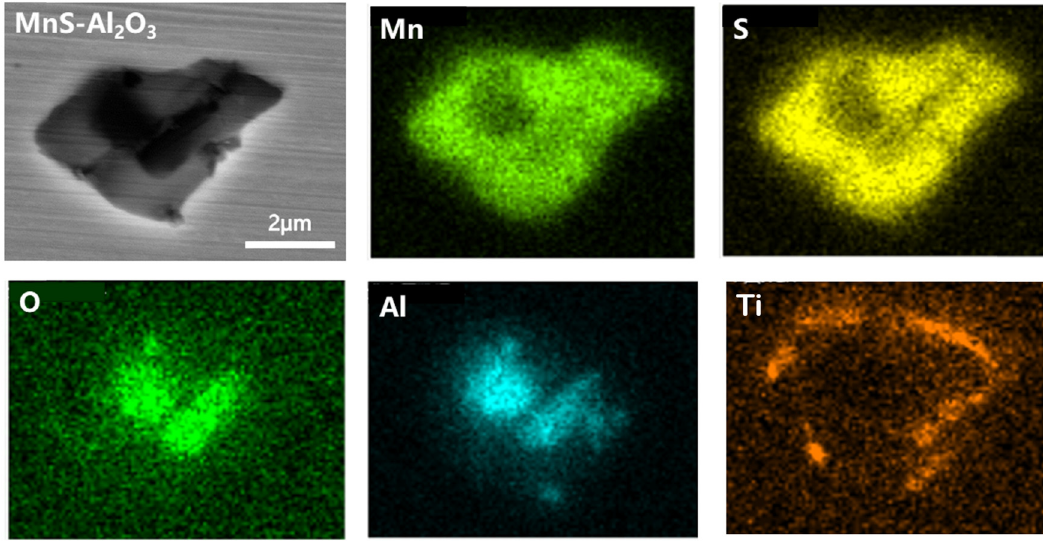
Figure 4: Elemental distribution of MnS – Al 2 O 3 inclusions in hot - rolled Y - free steel.